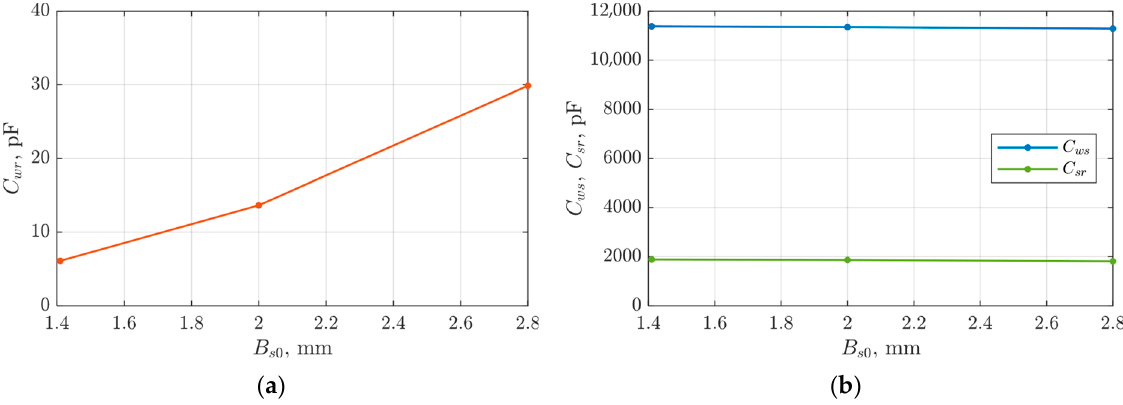
Figure 16. Characteristics of capacitance changes: ( a ) C wr , ( b ) C ws and C sr depending on the width of the oblique opening of the slot.